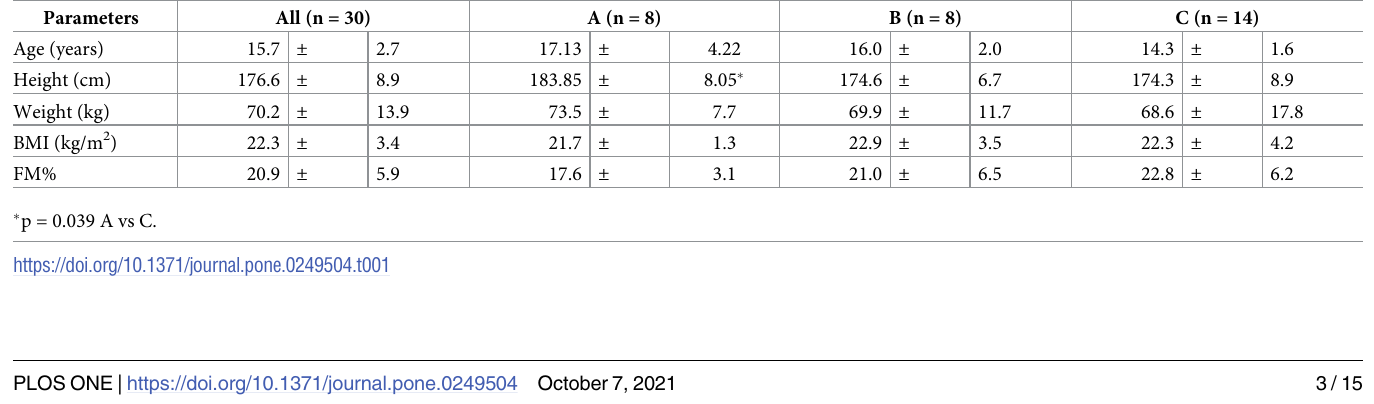
Table 1. Characteristics of the study sample (mean value ±